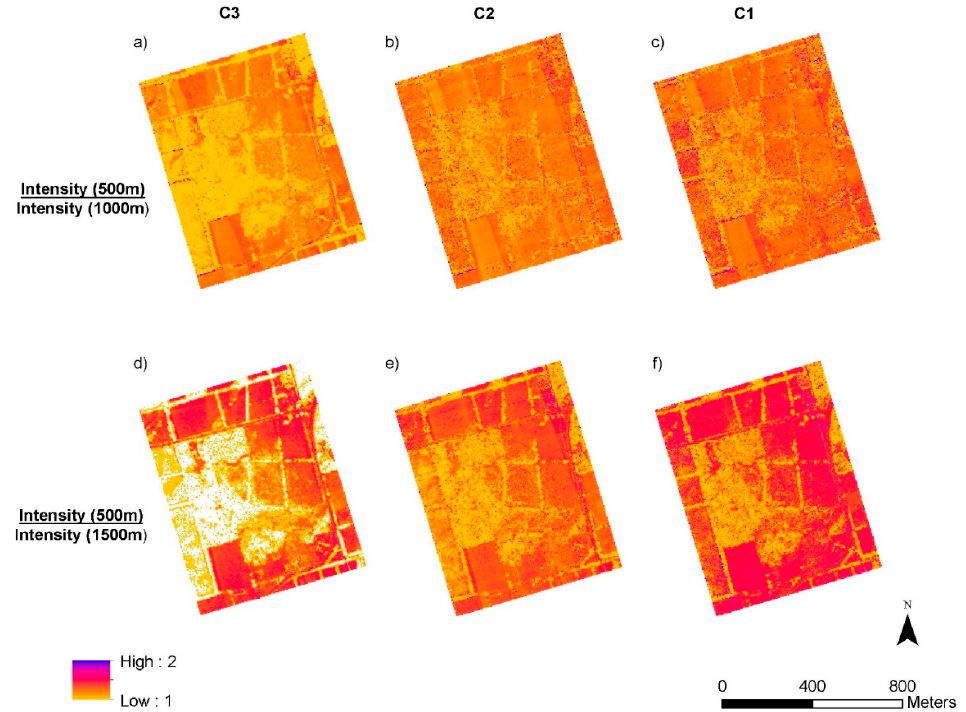
Figure 5. Single channels ratios of normalized to range 1000 m average intensity at 4 m × 4 m grid from all returns for each channel: C i (500 m) / C i (1000 m) in top figures, and C i (500 m) / C i (1500 m) in bottom figures. The channels are presented from left to right: C3, C2, and C1. White pixels represent no data.